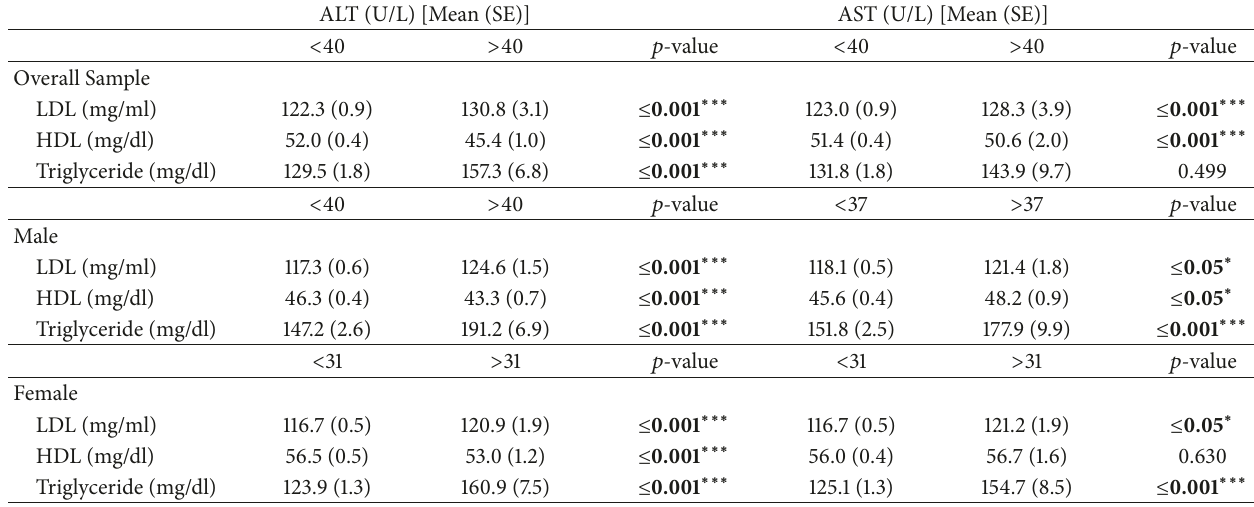
Table 3: Mean lipid biomarkers and liver enzymes.